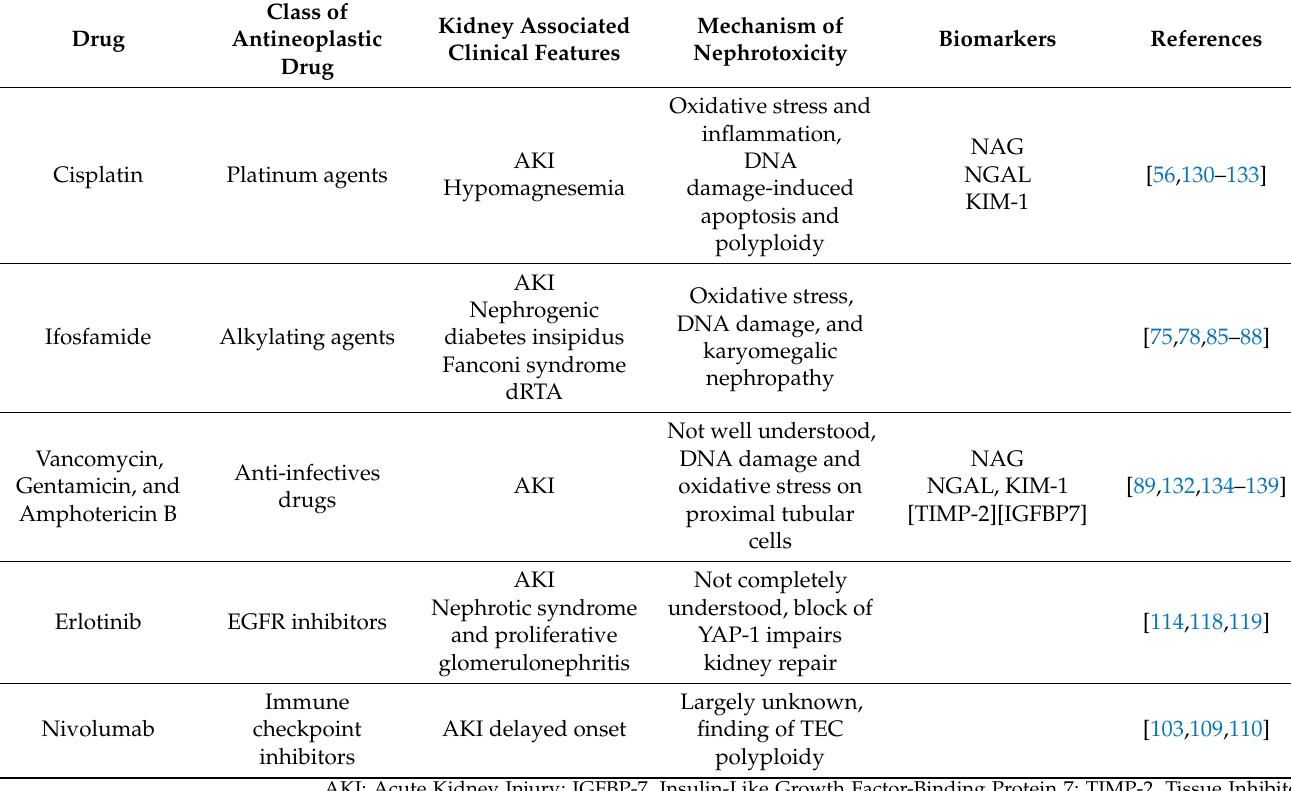
Table 2. Chemotherapy induced-AKI, mechanisms of nephrotoxicity and associated